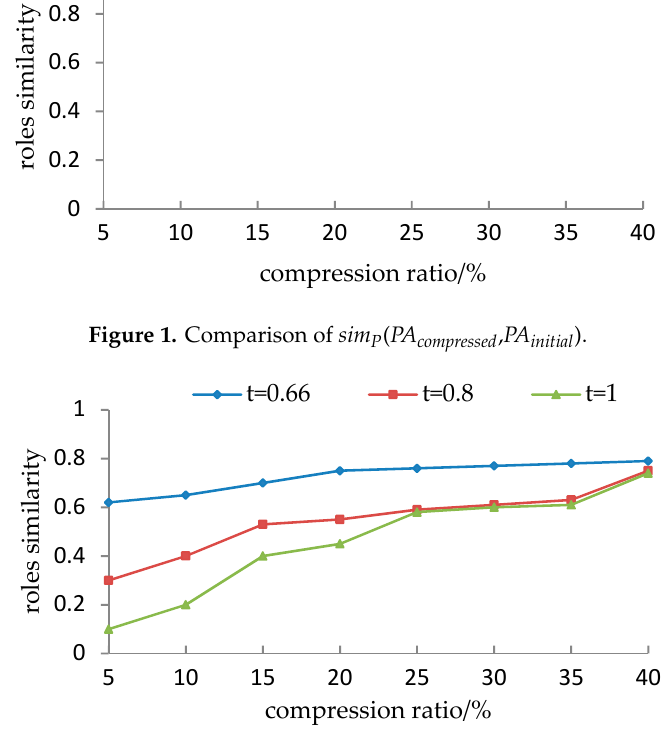
Figure 2. Comparison of sim U ( UA compressed , UA initial ).